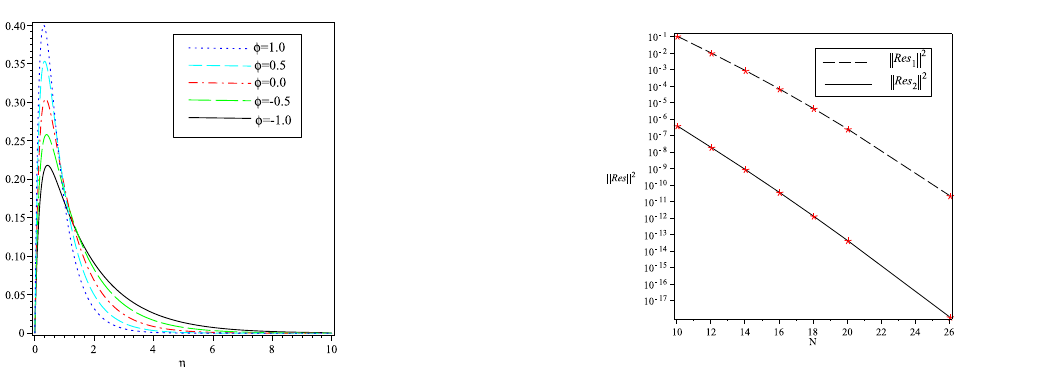
Fig. 11: The profile micro-rotation H ( η ) obtained by the indirect RBFs for different values of ϕ at β = 6 and ε = 0.1 .